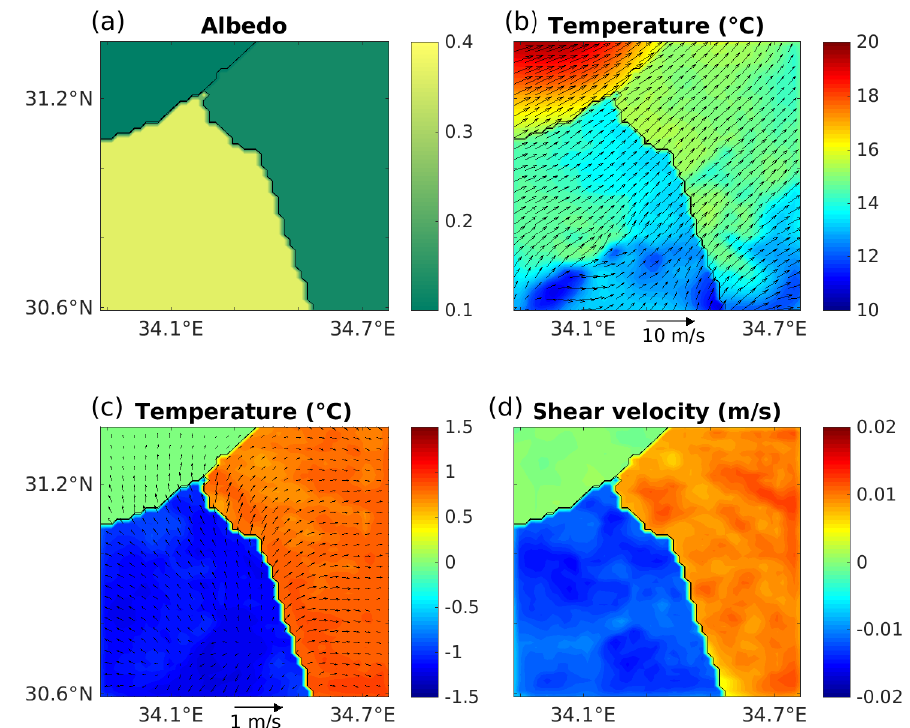
Figure 2. Results of the WRF simulation (averaged over December 2002 to February 2003) over the finest (inner) grid (Figure 1a), for which the albedo on the Israeli side is 0.13, while the albedo on the Egyptian side is 0.37. ( a ) Surface albedo. ( b ) Surface temperature (color) and 10 m wind (vectors). ( c ) The difference between the results presented in panel ( b ) and a control run for which the surface albedo on both the Israeli and the Egyptian sides is equal to 0.25. ( d ) The difference in winter mean shear velocity between the simulation in which the albedo is 0.13 and 0.37 on the Israeli and Egyptian sides and the control run for which the albedo on both sides is equal to 0.25. Note the increased temperature and wind activity on the vegetated (Israeli) side and the decrease on the bare dune side.